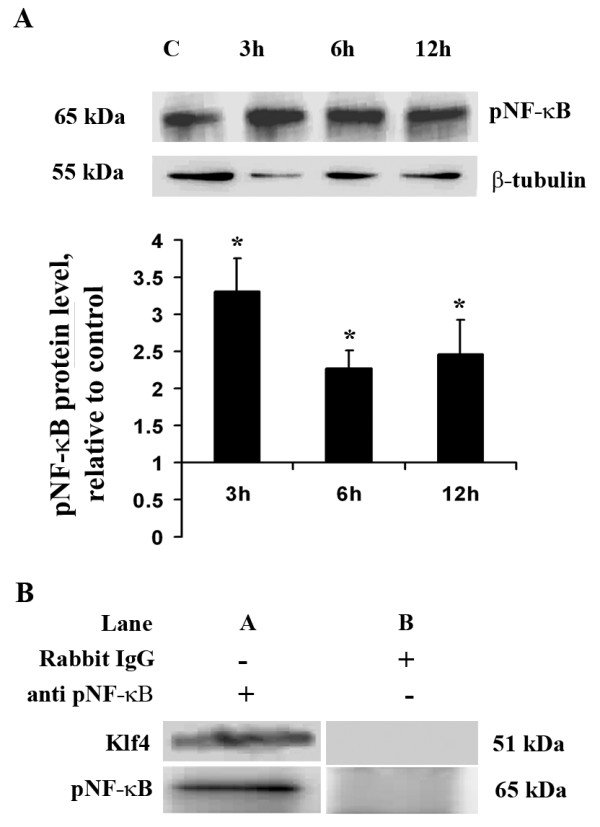
Klf4 interacts with pNF-κB during inflammation. (A) Immunoblot analysis of pNF-κB levels from total cellular extracts upon LPS treatment of BV-2 cells. The graph represents pNF-κB levels relative to untreated control sample at different time points. There is a significant increase in pNF-κB expression at all time points of LPS treatment compared to control. (B) Immunoblot and immunoprecipitation analysis of the interaction between pNF-κB and Klf4 in nuclear extracts of differently treated cells. Samples were 'pulled' down with a pNF-κB antibody. Lane A shows the blot for Klf4 in the upper panel and for pNF-κB in the lower panel in immunoprecipitate using anti-pNF-κB antibody, and lane B shows the same for immunoprecipitate using rabbit IgG as a control. *, **, Statistical differences in comparison to control values (* p < 0.05, ** p < 0.01).